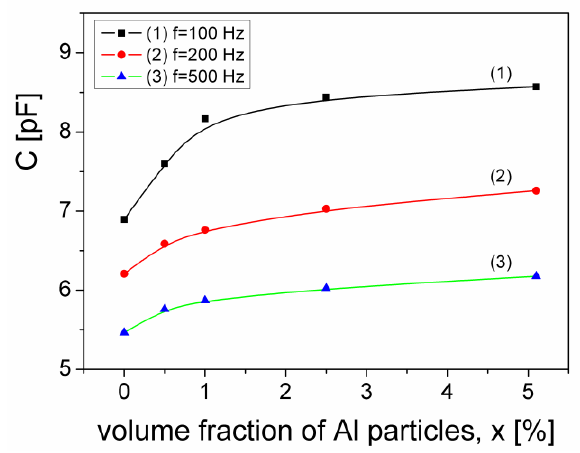
Figure 12. The volume fraction dependence of the electrical capacitance of a capacitor with the investigated composite samples as dielectric, at three frequencies.